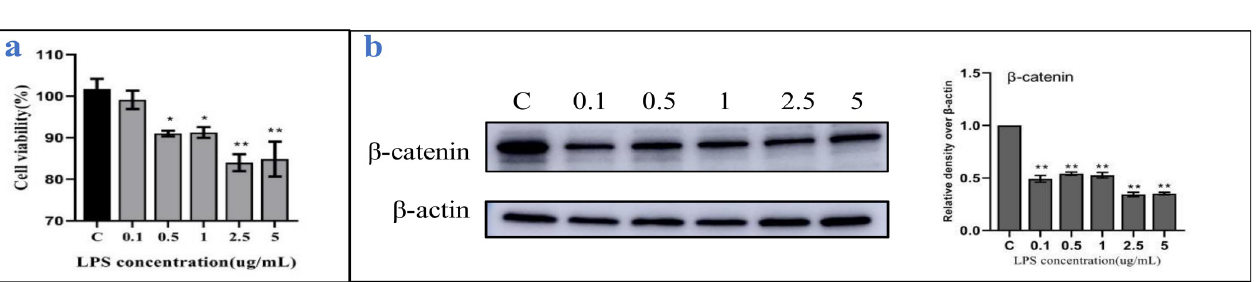
Fig 1. LPS inhibits the proliferation and expression of β -catenin in BMECs. BMECs were treated with 0–5 μ g/mL LPS for 24 h. (a) The cellular activity of LPS-stimulated BMECs at 24 h was assayed using the CCK-8 method. (b) Effect on the expression of β -catenin in LPS-stimulated BMECs. Western blotting was used to determine the relative levels of β -catenin. β -actin was used as a control. Data are expressed as mean ± SD of 3 independent experiments. � 0.01 < P < 0.05, �� P <